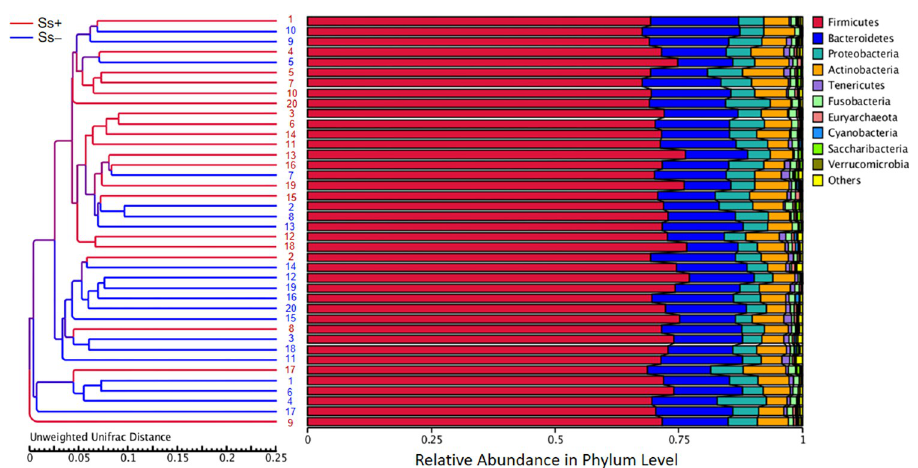
Fig 5. Clustering using the unweighted pair group method with arithmetic mean (UPGMA). UPGMA cluster tree based on unweighted UniFrac distances between CKD patients with or without S . stercoralis infection. The red branches represent individuals with S . stercoralis infection (Ss+) and the dark blue branches indicate uninfected (Ss-) individuals.